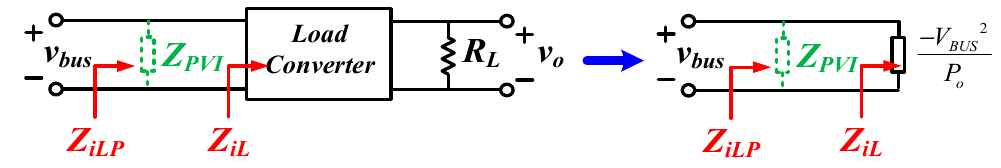
Figure 13. Physical meaning of the parallel type virtual impedance.